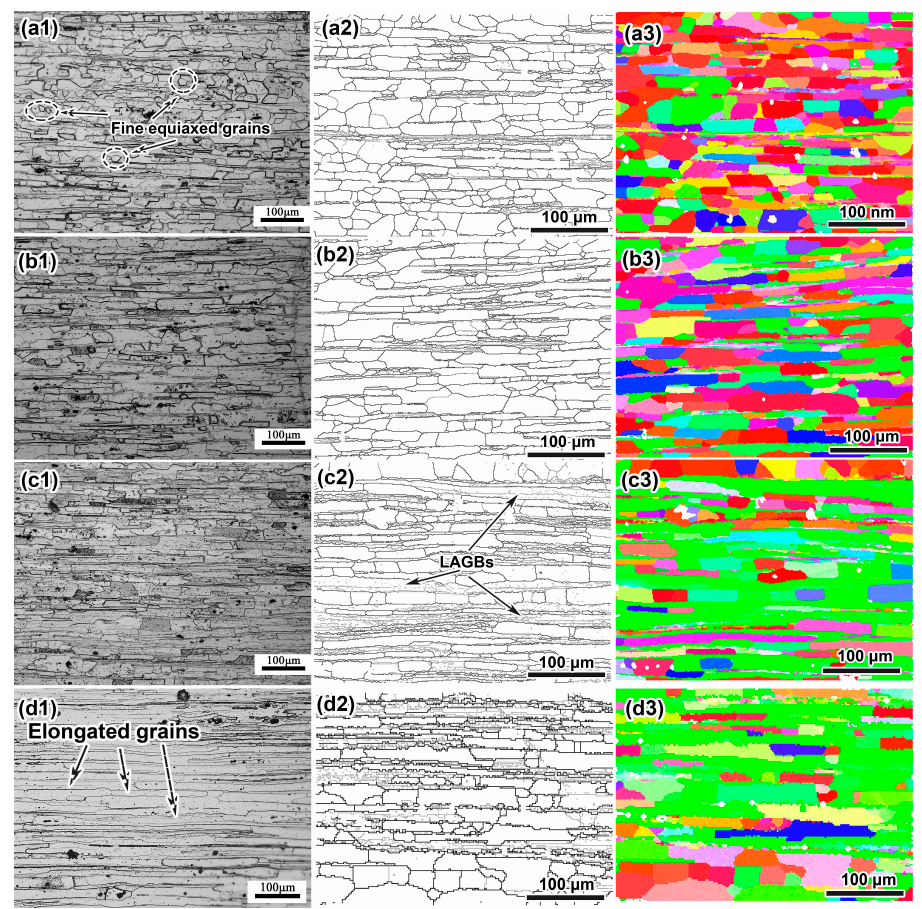
Figure 7. OM ( a1 – d1 ) and EBSD maps ( a2 – d2 for grain boundaries, a3 – d3 for grain orientations) of alloys after recrystallization: ( a ) MSR 1 ; ( b ) MSR 2 ; ( c ) MSR 3 ; ( d ) CHR. Metals 2020 , 10 , x FOR PEER REVIEW Room temperature tensile engineering stress-strain curves, and the ultimate tensile strength (UTS), yield strength (YS), and elongation ( δ ), of all rolled plates after solution and T6 aging are